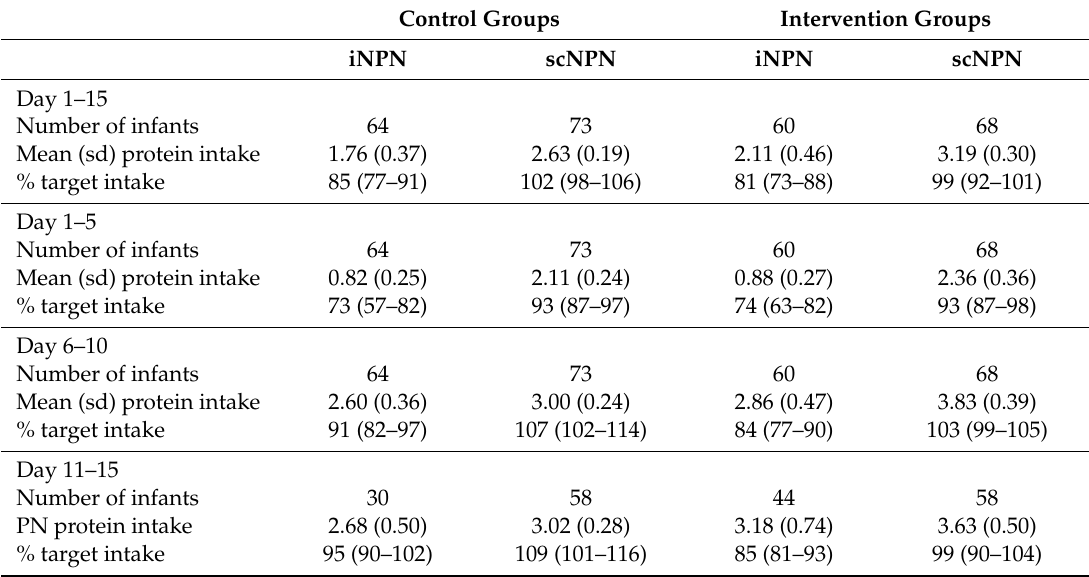
Table 4. The target attainment for protein intake compared between the iNPN and scNPN RCTs. Target attainment (%) defined as median (IQR) percentage of target protein intake achieved. Comparison made at two protein doses: standard (control) and high (intervention) in infants receiving < 50% enteral feeds ( < 75 mL / kg / d). For all iNPN versus scNPN comparisons, p < 0.01.